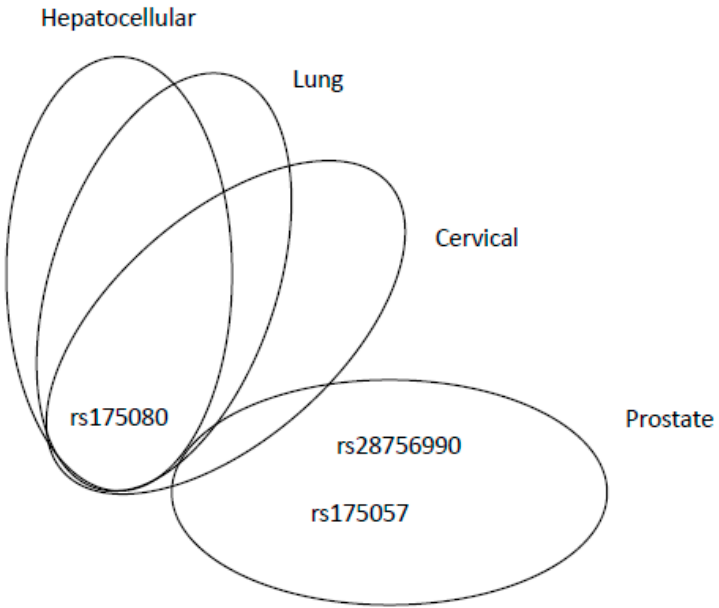
Figure 4. Venn diagram showing relevant MLH3 SNPs, associated with adverse effects, in overlap among different cancer types or peculiar for specific malignancies.